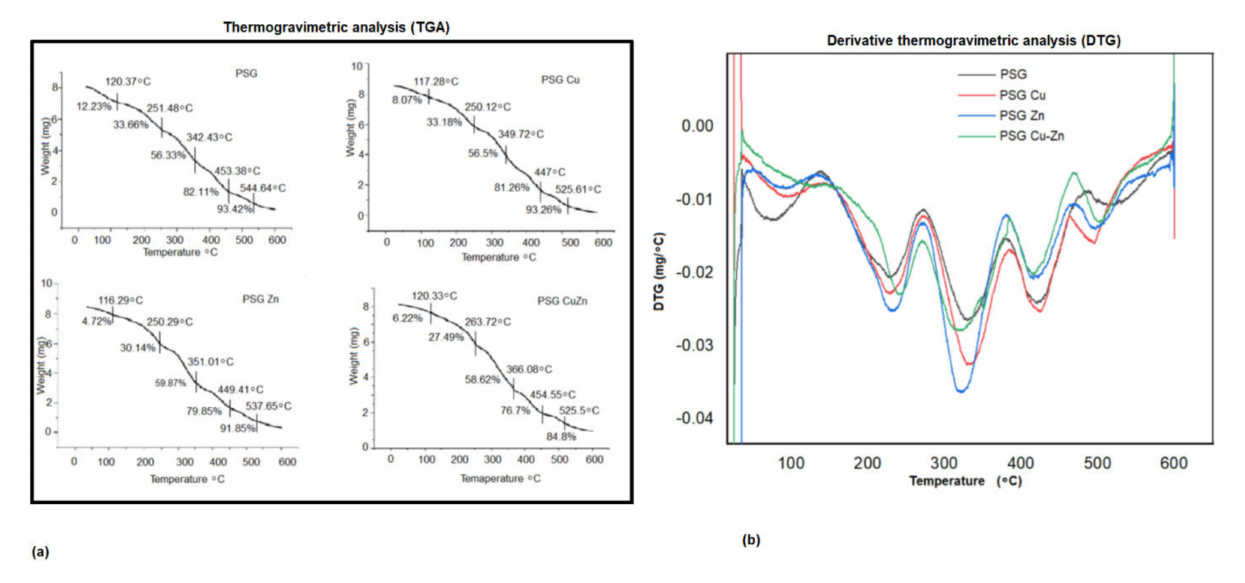
Figure 5. Thermogravimetric analysis of ( a ) PSG, PSG-Cu, PSG-Zn, and PSG-CuZn films. ( b ) Deriva- tive plot of the thermogravimetric analysis of PSG, PSG–Cu, PSG–Zn, and PSG–CuZn